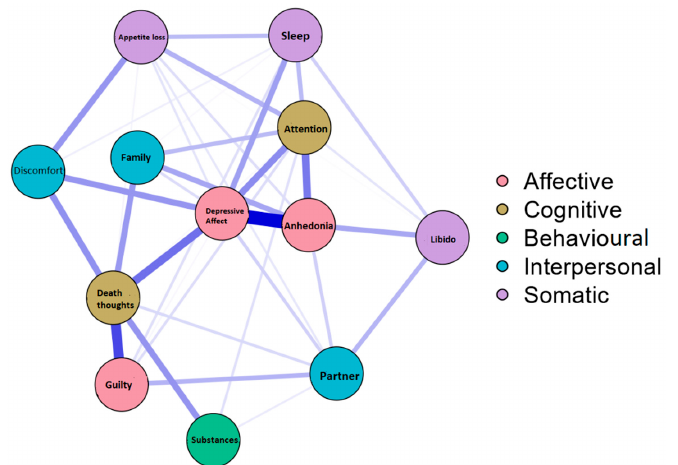
Figure 1. Estimated correlation network for the factors evaluated with the DCET (temporal moment ‘month’).